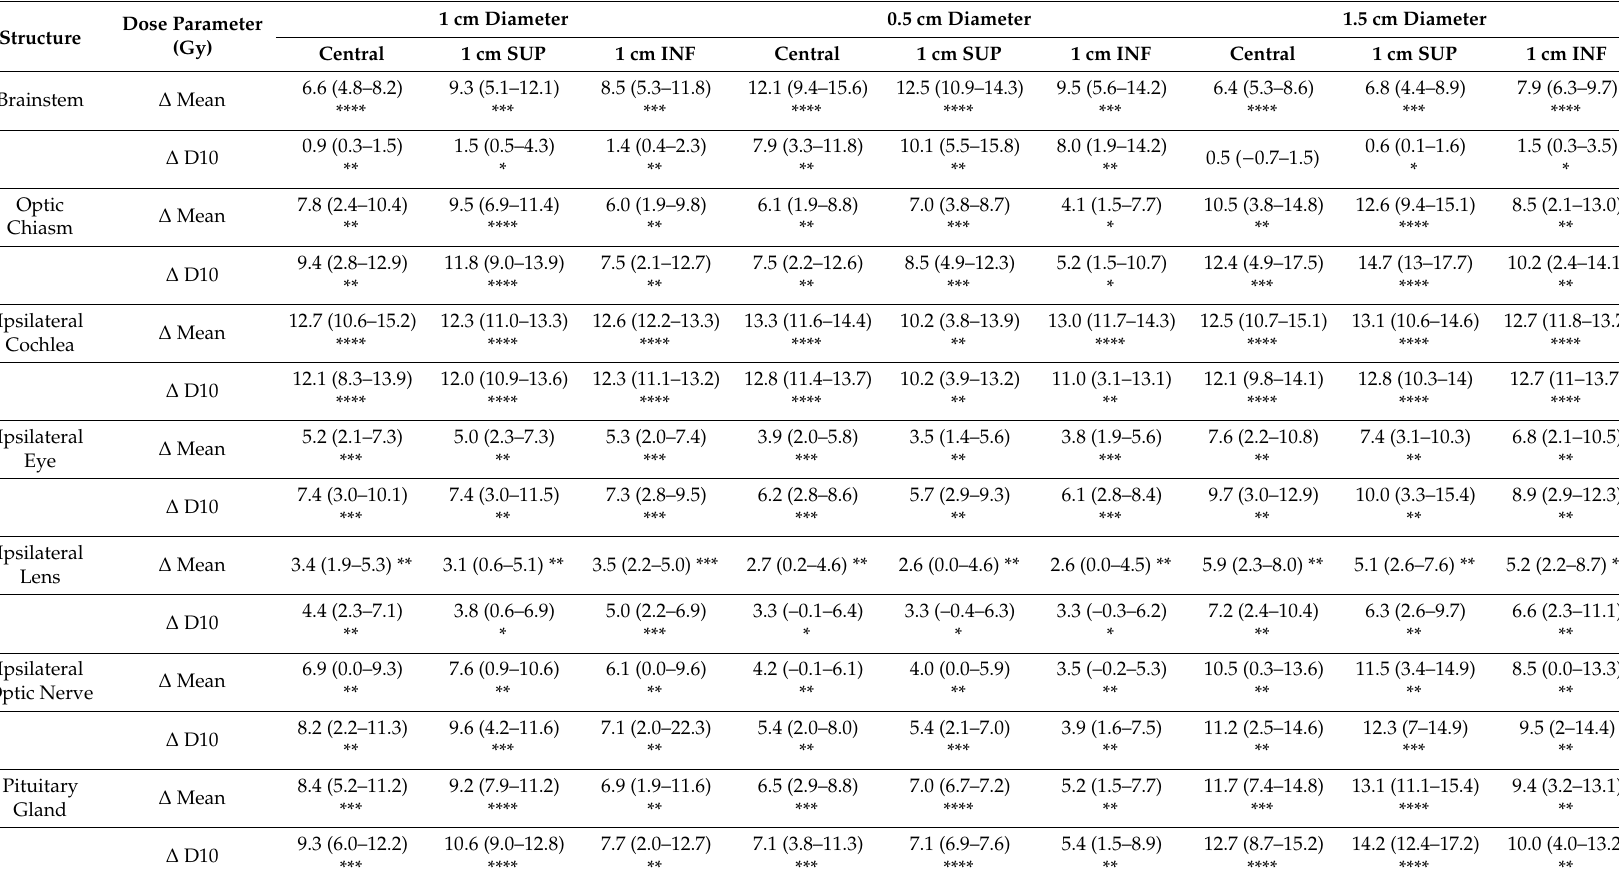
Table 4. Comparison of mean and D10 dose di ff erence ( ∆ IMRT (Gy)-IMPT (Gy(RBE))) for critical structures averaged across 6 patient plans collected for infratentorial medulloblastoma (prescribed dose of 54 Gy / Gy(RBE) (23.4 Gy / Gy(RBE) craniospinal irradiation with 30.6 Gy / Gy(RBE)